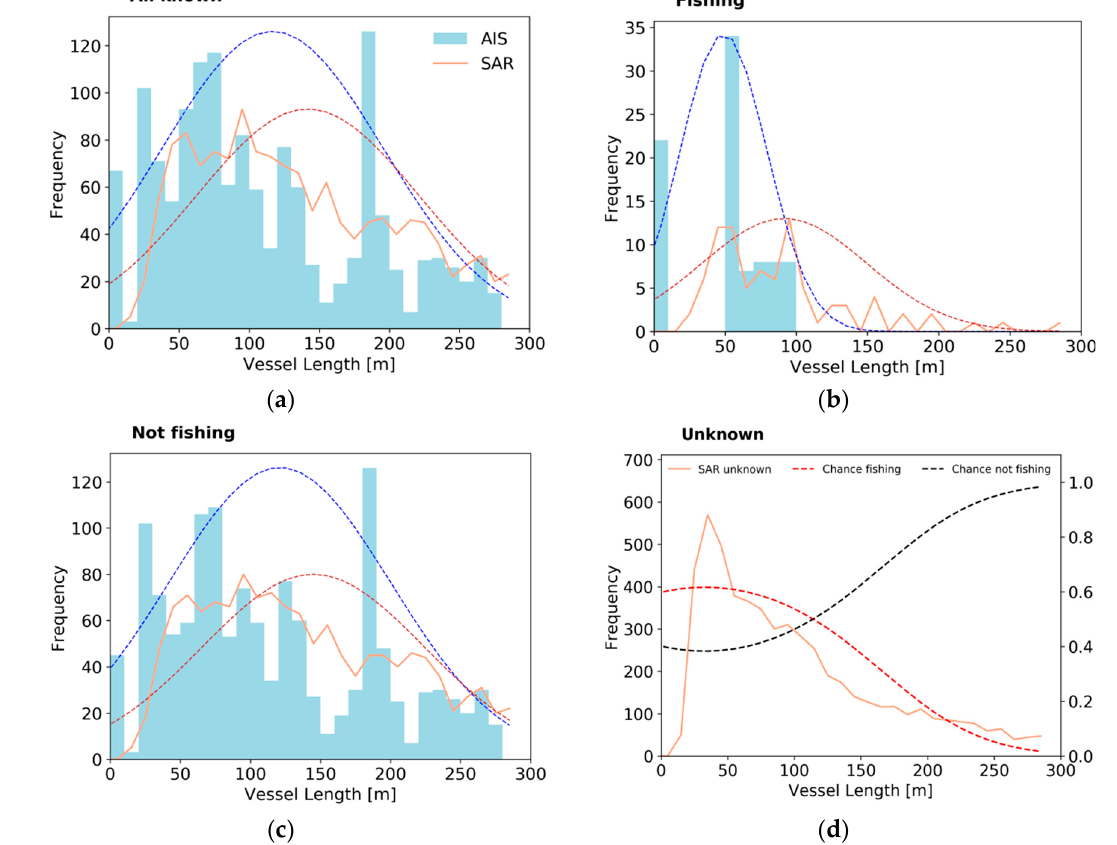
Figure 17. Statistical discrimination of vessel activity according to vessel length. Panels ( a ), ( b ) and ( c ) show the distribution of vessel length for matched AIS (blue bars) and SAR (orange solid line), for all known vessels, fishing vessels, and non-fishing vessels, respectively. Dashed lines show the skewed Gaussian distribution that best fits the underlying data. Panel ( d ) shows the SAR-determined vessel lengths for unmatched vessels (orange solid line), and the likelihood that the vessel is fishing (red dashed) or not fishing (black dashed) according to the likelihood that the vessel belongs to the probability density function associated with the distributions in panels ( a ) through ( c ).